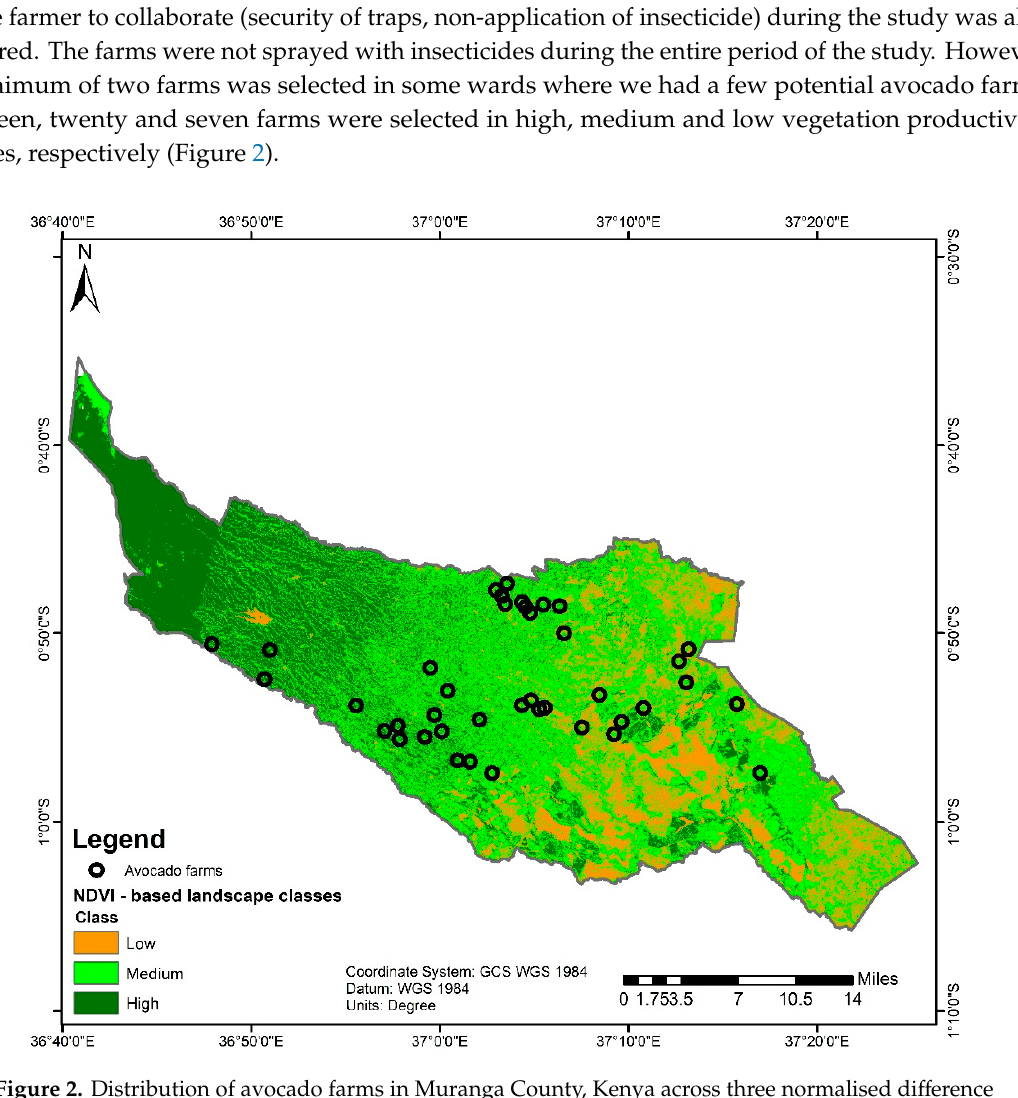
Figure 2. Distribution of avocado farms in Muranga County, Kenya across three normalised difference vegetation index (NDVI)- based landscape classification.